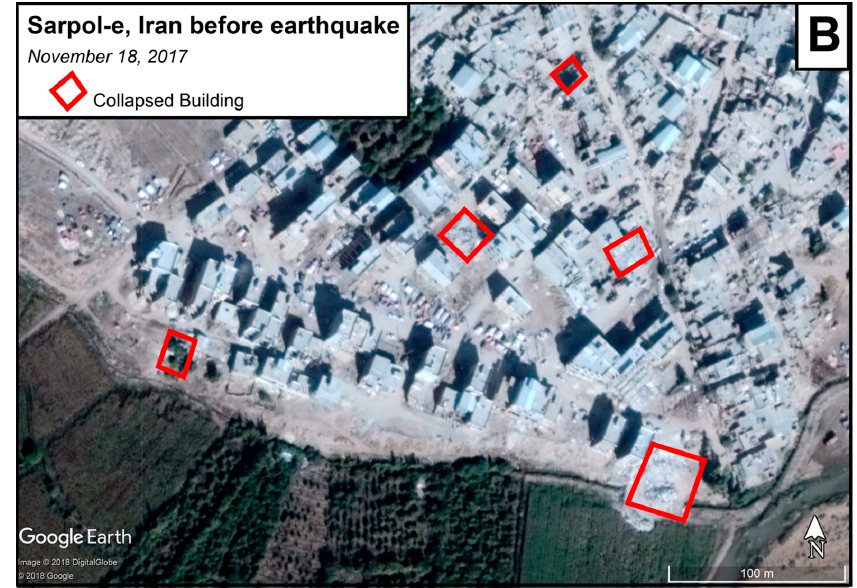
Figure 4. Detail of damage to buildings in Sarpol-e, Iran using Google Earth historical imagery. Collapsed buildings are highlighted in red. All damage is within PAA 4980 covering the city of Sarpol-e. The PAA detection using Sentinel-1 imagery does not identify damage to specific buildings, but detects areas containing damage.